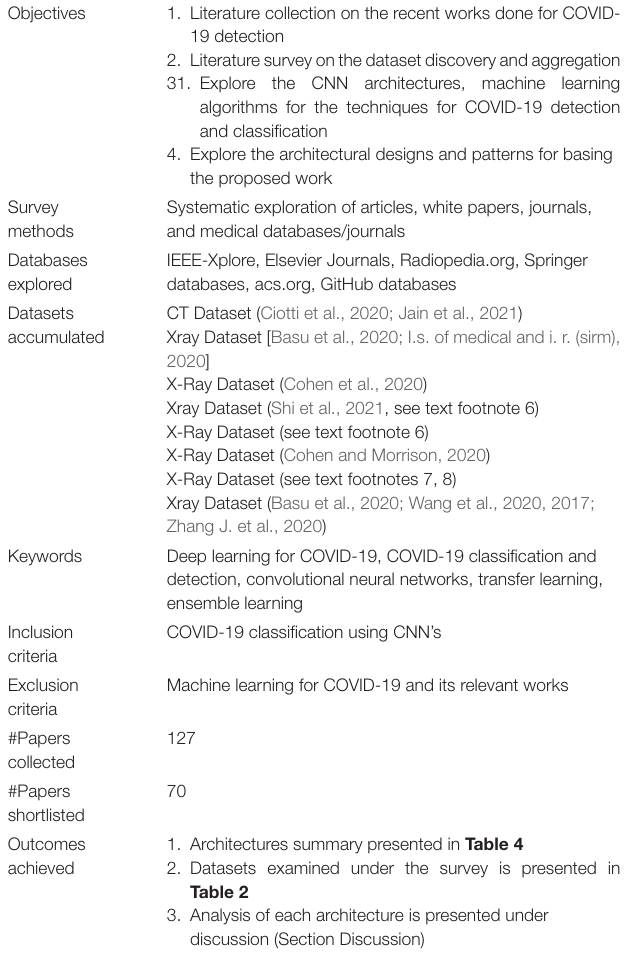
TABLE 6 | Survey framework. Objectives